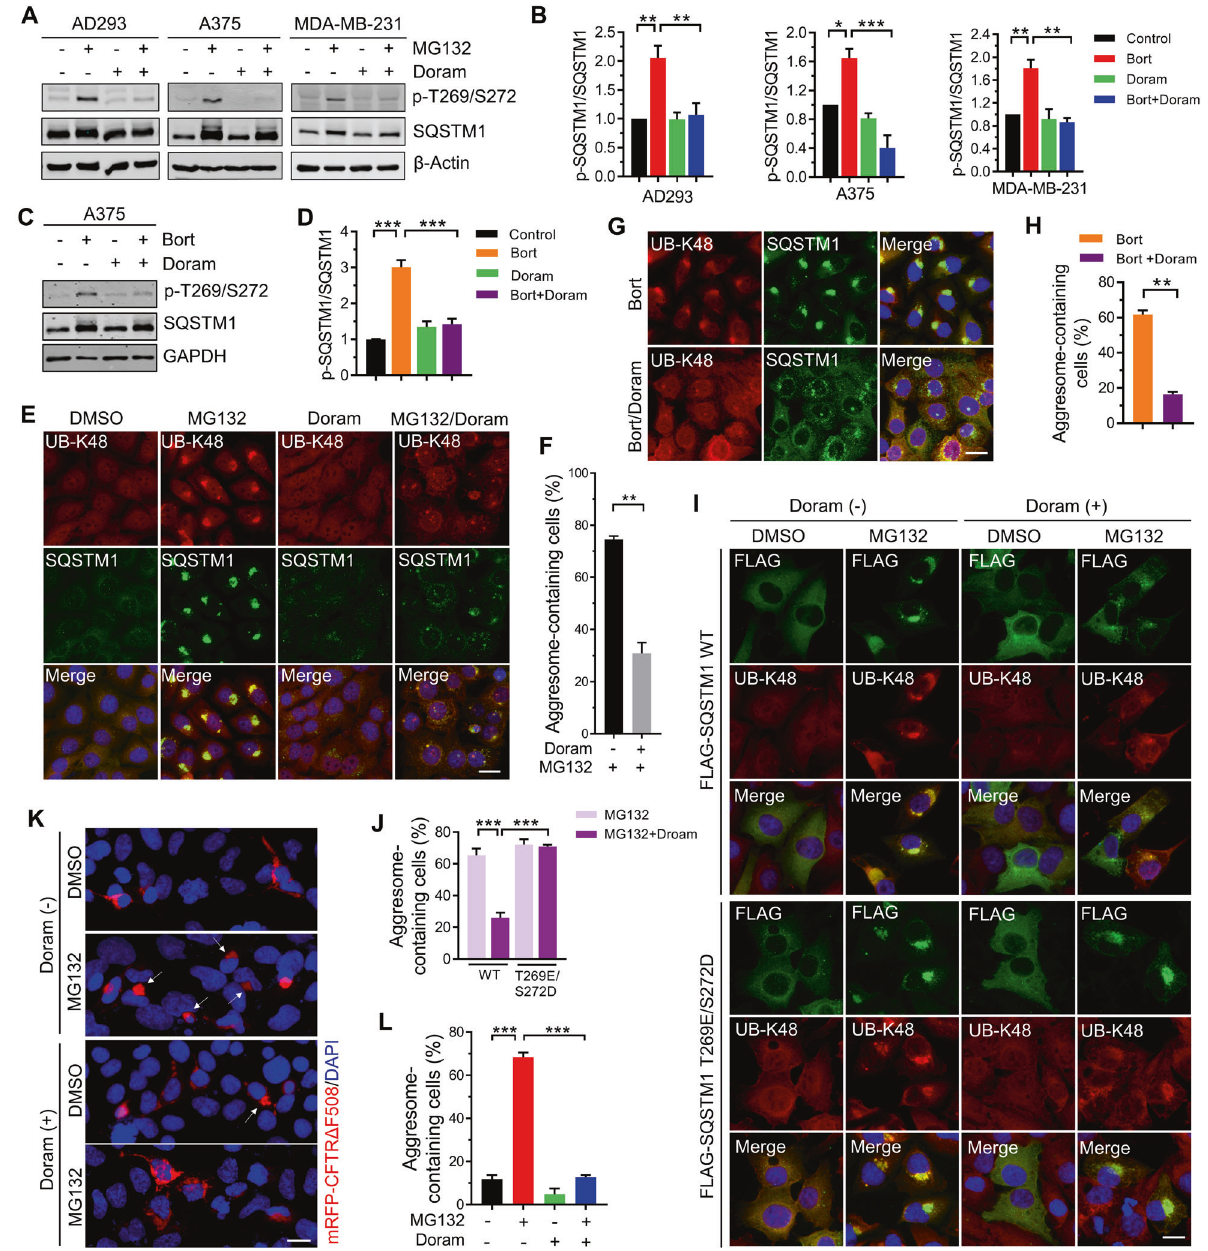
Fig. 4 Doramapimod prevents the aggresome formation via inhibiting the phosphorylation of SQSTM1(Thr269/Ser272). A AD293, A375 and MDA-MB-231 cells were treated with DMSO (control), or MG132 (2 μ M), and Doramapimod (50 μ M), alone or in combination for 14 h. The whole-cell lysates were subjected to western blot analysis with indicated antibodies. B Quantitative analysis of results in ( A ). Data are mean ± SEM of three independent experiments. * P < 0.05, ** P < 0.01, *** P < 0.001. C A375 cells were treated with DMSO (control), or Bortezomib (1 μ M), and Doramapimod (50 μ M), alone or in combination for 14 h. The whole-cell lysates were subjected to western blot analysis with indicated antibodies. D Quantitative analysis of results in ( C ). Data are mean ± SEM of 3 independent experiments. * P < 0.05, ** P < 0.01. E A375 cells were treated with DMSO (control), or MG132 (2 μ M), and Doramapimod (50 μ M), alone or in combination for 14 h. The aggresome formation was analyzed by immunostaining with anti-UB-K48 (Red) and anti-SQSTM1 (Green) antibodies. Nuclei were stained with DAPI (blue). Scale bar: 20 μ m. F Quantitative analysis of results in ( E ). G A375 cells were treated with Bortezomib (1 μ M), or Bortezomib (1 μ M)/ Doramapimod (50 μ M) for 14 h. The aggresome formation was analyzed by immunostaining with anti-UB-K48 (red) and anti-SQSTM1 (green) antibodies. Nuclei were stained with DAPI (blue). Scale bar: 20 μ m. H Quantitative analysis of results in ( G ). I A375 cells were transfected with plasmids expressing FLAG-SQSTM1(WT) or FLAG-SQSTM1(T269E/S272D) for 24 h, and then treated with DMSO (control), or MG132 (2 μ M), and Doramapimod (50 μ M), alone all in combination for 14 h. The aggresome formation was analyzed by immunostaining with anti-UB-K48 (Red) and anti-FLAG (green) antibodies. Nuclei were stained with DAPI (blue). Scale bar: 20 μ m. J Quantitative analysis of results in ( I ). K AD293 cells were transfected with plasmids expressing mRFP-CFTR Δ F508 for 24 h, and then treated with DMSO (control), or MG132 (2 μ M), and Doramapimod (50 μ M), alone all in combination for 14 h. The aggresome formation was analyzed by fl uorescence microscope. Nuclei were stained with DAPI (blue). Scale bar: 20 μ m. L Quantitative analysis of results in ( K ). For F , H , J , and L , at least 40 cells were randomly selected from each group to score for aggresomes. Data are mean ± SEM of three independent experiments. ** P < 0.01, *** P < 0.001.